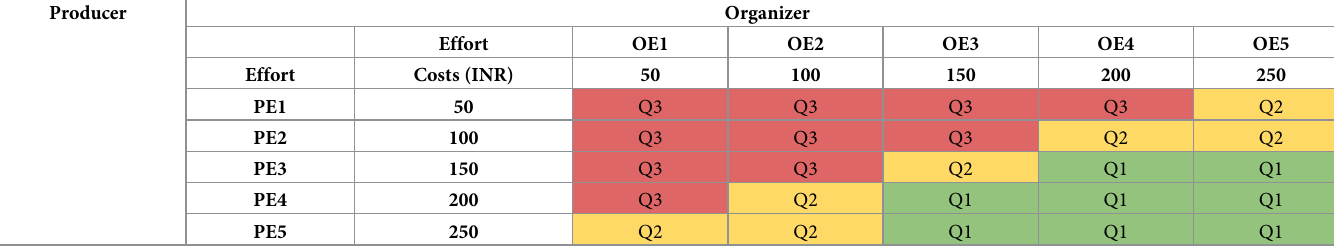
Q1 = excellent quality, Q2 = standard quality, and Q3 = sub-standard